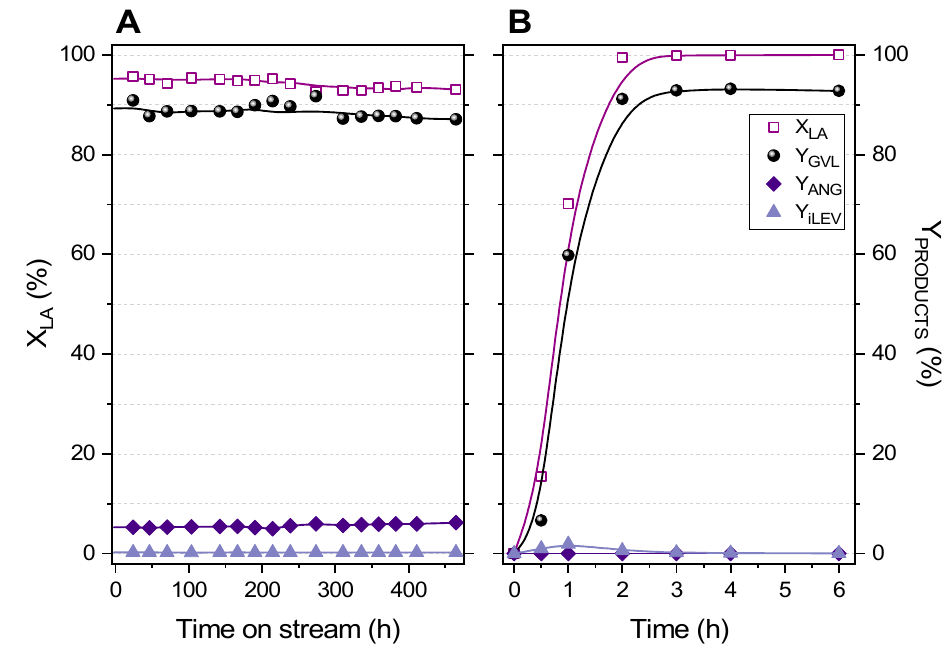
Figure 3. ( A ) Conversion and product yield profiles in the transformation of LA versus the time on stream obtained in the packed-bed reactor charged with the bifunctional Zr–Al-Beta catalyst operating under steady-state conditions. Reaction conditions: temperature = 170 °C; catalyst weight = 0.25 g; LA concentration = 6 g·L − 1 ; feed flow rate = 0.05 mL·min − 1 ; contact time = 5 min·g·mL − 1 . ( B ) Product yields in the transformation of LA in batch mode operation. Reaction conditions: temperature = 170 °C; catalyst loading = 12.5 g·L − 1 ; LA concentration = 18 g·L − 1 .